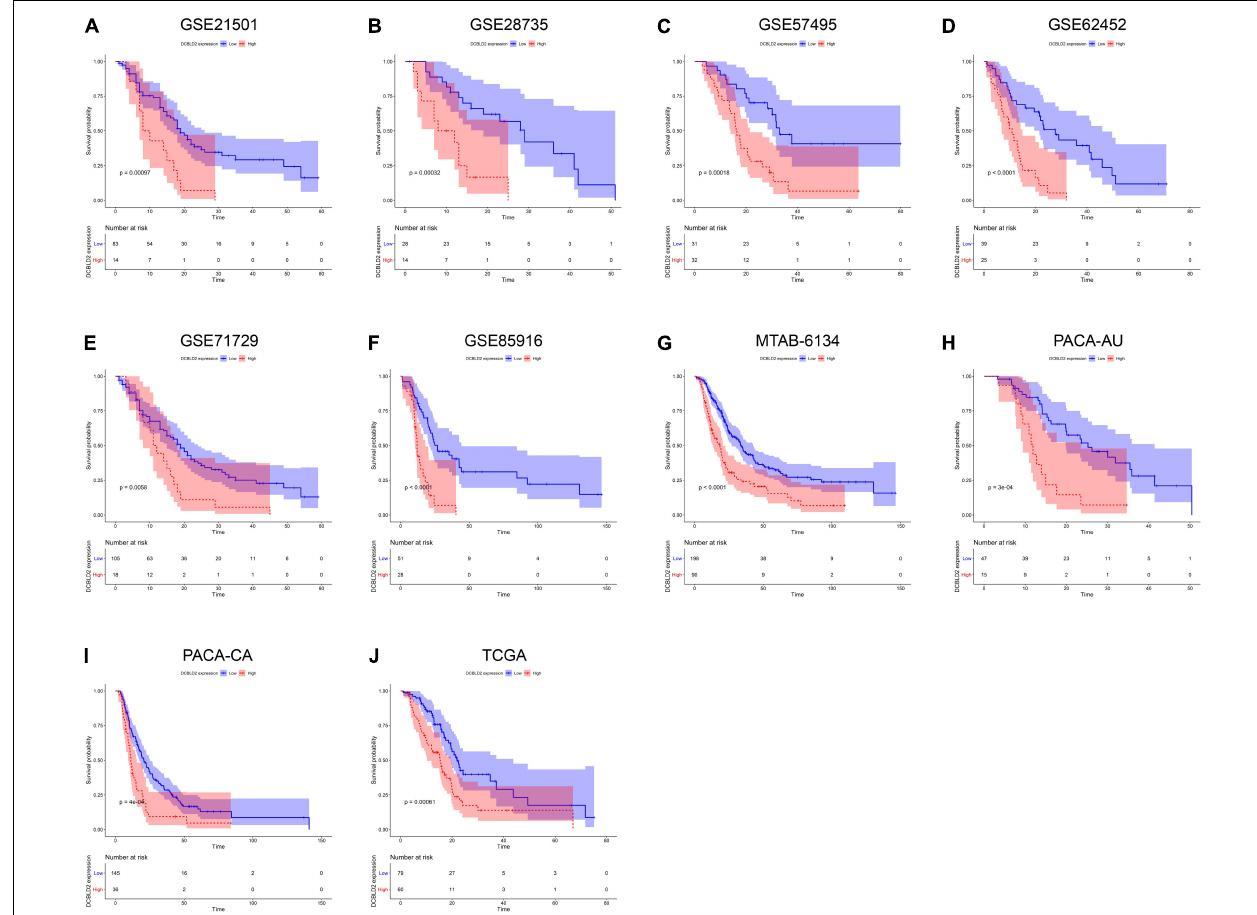
FIGURE 3 | Prognostic validation of DCBLD2 in PDAC. (A–J) K–M curves estimated the OS difference between low- and high-expression groups in ten independent PDAC cohorts. The statistical significance of differential survival was evaluated by log-rank